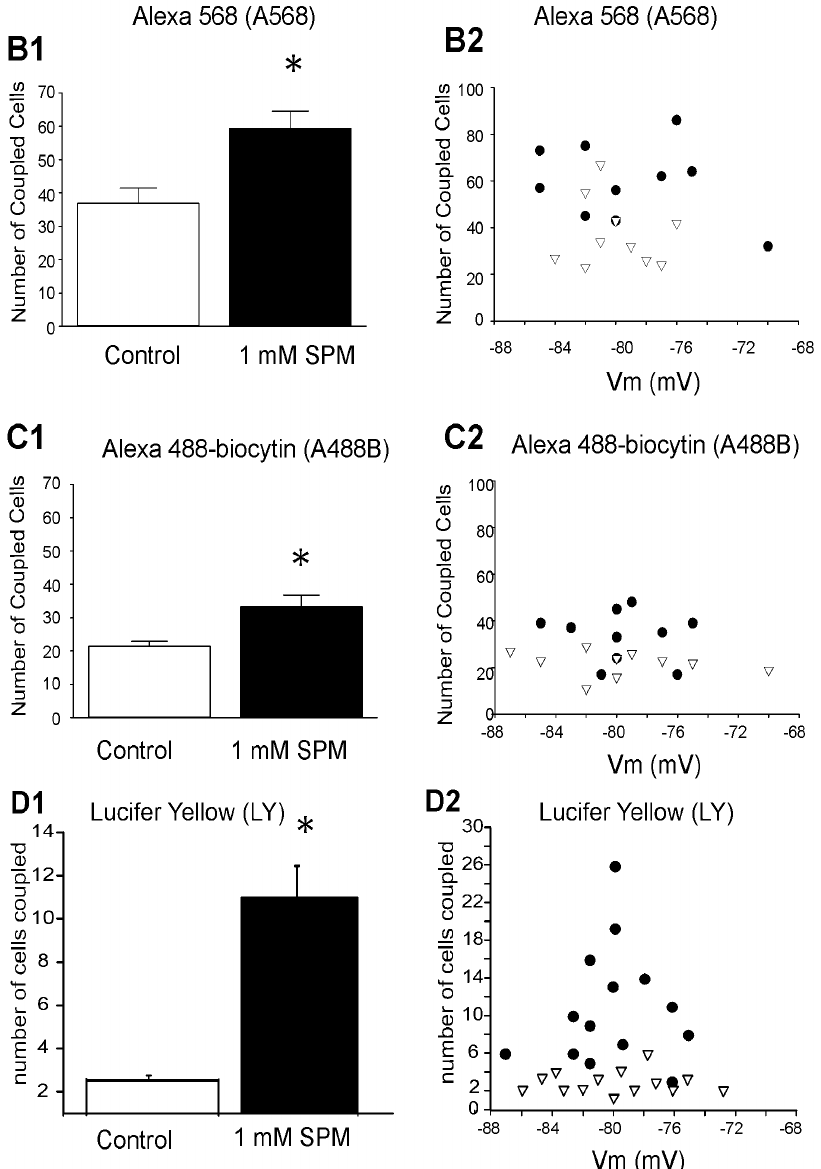
Figure 5. Effect of intracellular spermine (SPM) on propagation of electrically neutral and charged dyes through the as- troglial syncytium. ( A1 ) Using neutral-polar dye SB, electrically neutral amine Sulforhodamine B (2 mM), 1 mM spermine (SPM) included in the pipette has no effect on the amount of coupling cells: control (60.4 ± 2.9, N = 6) compared to the SPM-treated group (60.7 ± 2.5, N = 6). ( B1 ) Using negatively charged dye A568, Alexa 568 (200 µM), 1 mM spermine increases the extent of coupling, control (36.9 ± 4.6, N = 10) compared to the SPM-treated group (59.3 ± 5.2, N = 10). ( C1 ) 1 mM spermine increases the amount of coupling of cells filled with negatively charged Alexa 488-biocytin (100 µM), control (21.4 ± 1.6, N = 11) compared to the SPM-treated group (33.3 ± 3.4, N = 10). The asterisks indicate a significant difference between the control and SPM-treated groups. ( D1 ) 1 mM SPM strongly increases the amount of coupling of cells filled with negatively charged LY, Lucifer Yellow (100 µM), control (3.5 ± 1.7, N = 15) compared to SPM-treated group (11.5 ± 3.6, N = 14). The asterisks indicate a significant difference between the control and SPM-treated groups ( p < 0.01), error